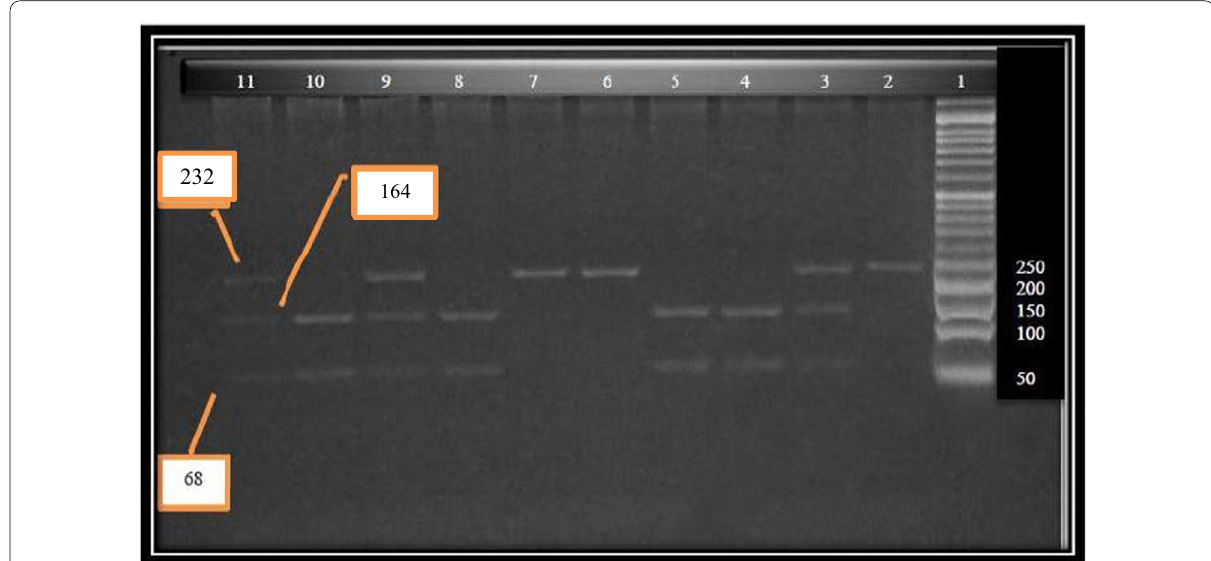
Fig. 1 PCR–RFLP band pattern of CDKN2A/B gene polymorphism (rs10811661) on a 3% agarose gel. Lines 1: Marker of DNA. Lines 2, 6 and 7: CC genotype 232 bp. Lines 4, 5, 8 and 10: TT genotype 164 and 68 bp. Lines 3,9 and 11: TC genotype 232, 164 and 68 bp